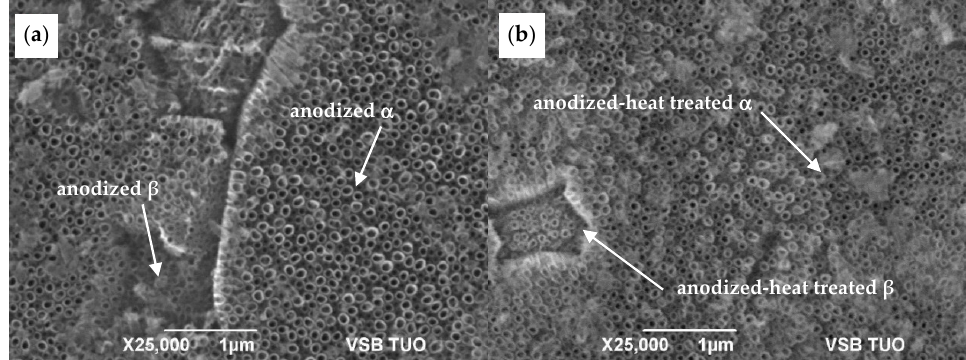
Figure 6. SEM SEI images of the polished sample in ( a ) as-anodized and ( b ) anodized-heat treated state.